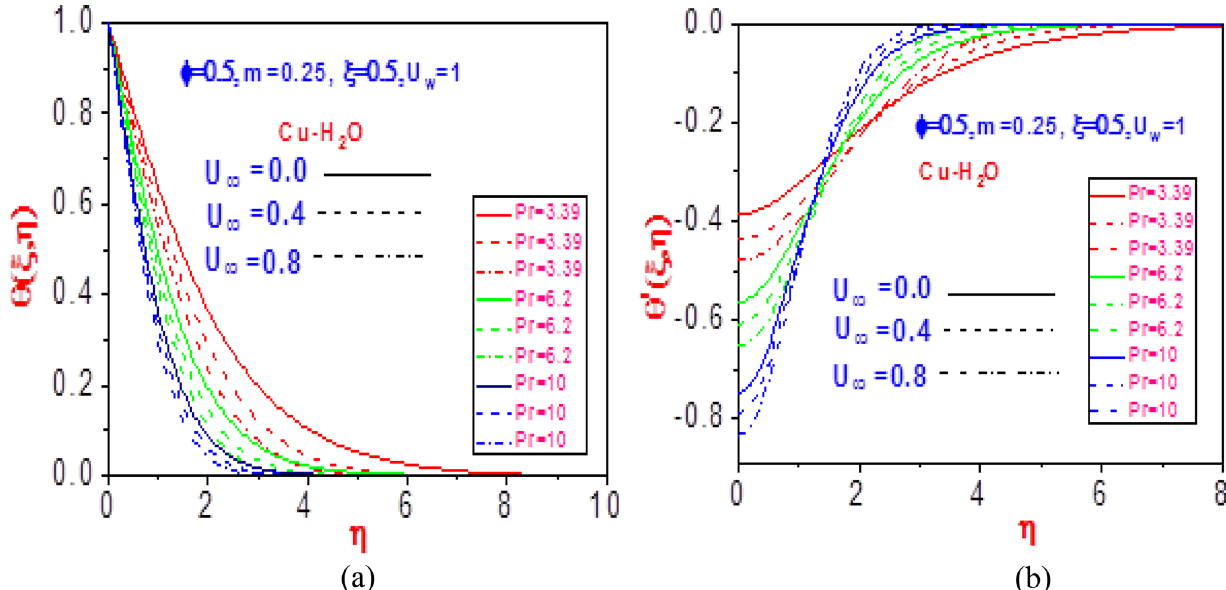
Figure 9. Profiles of ( a ) temperature θ(ξ , η) and ( b ) missing temperature slope θ ′ (ξ , η) with different values of U ∞ and Pr for Cu-H